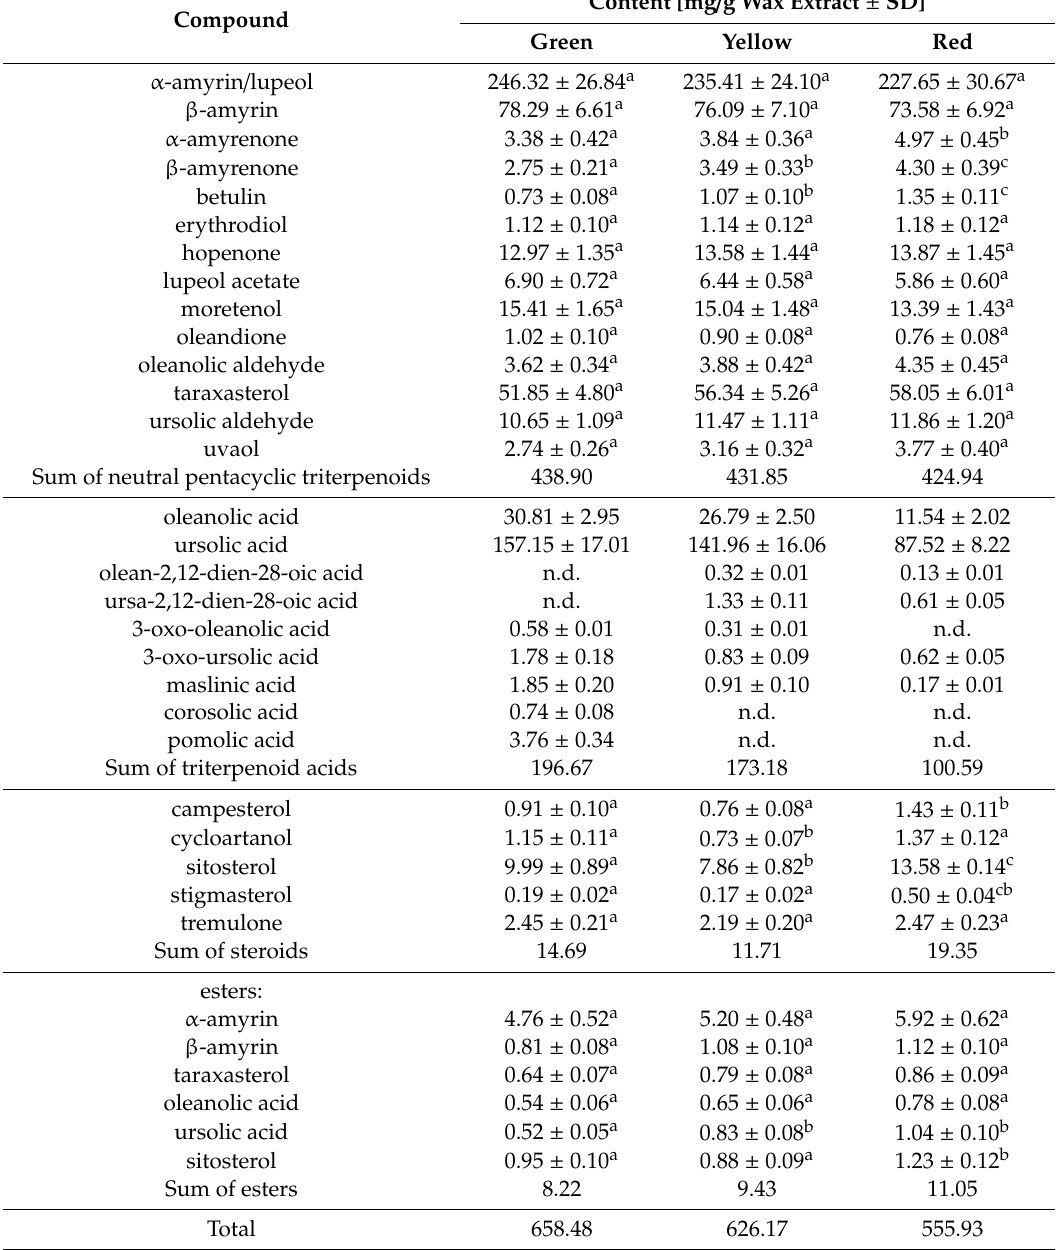
Table 3. Content of triterpenoids in cuticular waxes during strawberry tree Arbutus unedo fruit